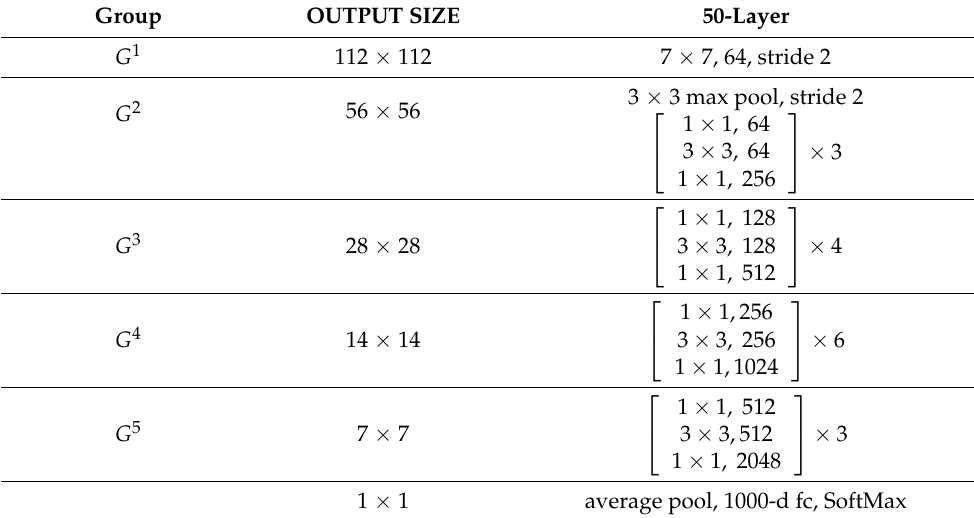
Table 1. ResNet-50 architecture for